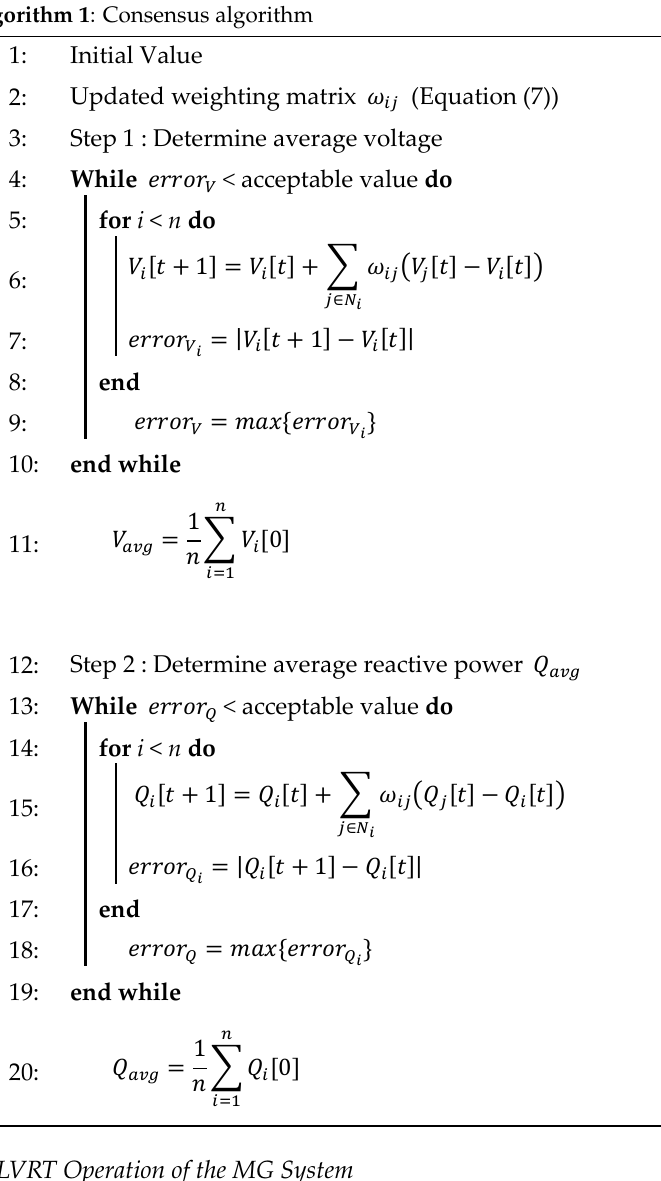
Energies 2018 , 11 , x 8 of 18